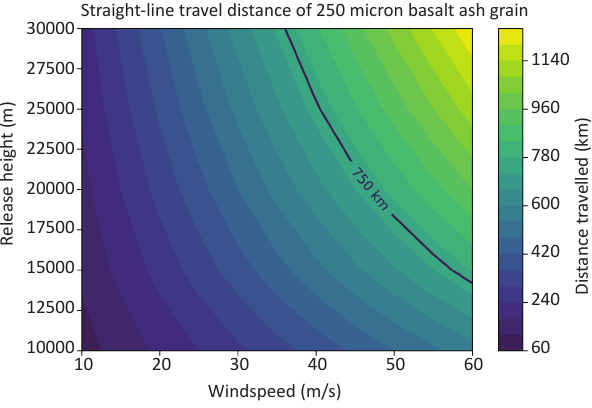
Figure 4: A model evaluation of the necessary plume heights and atmospheric wind speeds required for long distance ash dispersal, based on the method of Steven- son et al. [2015]. The model uses conservative estimates of 250 µm basaltic ash particle size and a 750 km trans- port distance (shown as a black line). The input pa- rameters use a basaltic glass density of 2800 kg m -3 , a grain sphericity of 0.7, a size-dependent density func- tion [Bonadonna and Phillips 2003], and a Ganser fall velocity model. The model makes the unrealistic as- sumption of constant wind velocities at all altitudes and in a straight line from source to deposition, mean- ing that the output is a minimum estimate of the re- quired plume heights/wind speeds to distribute ash particles these